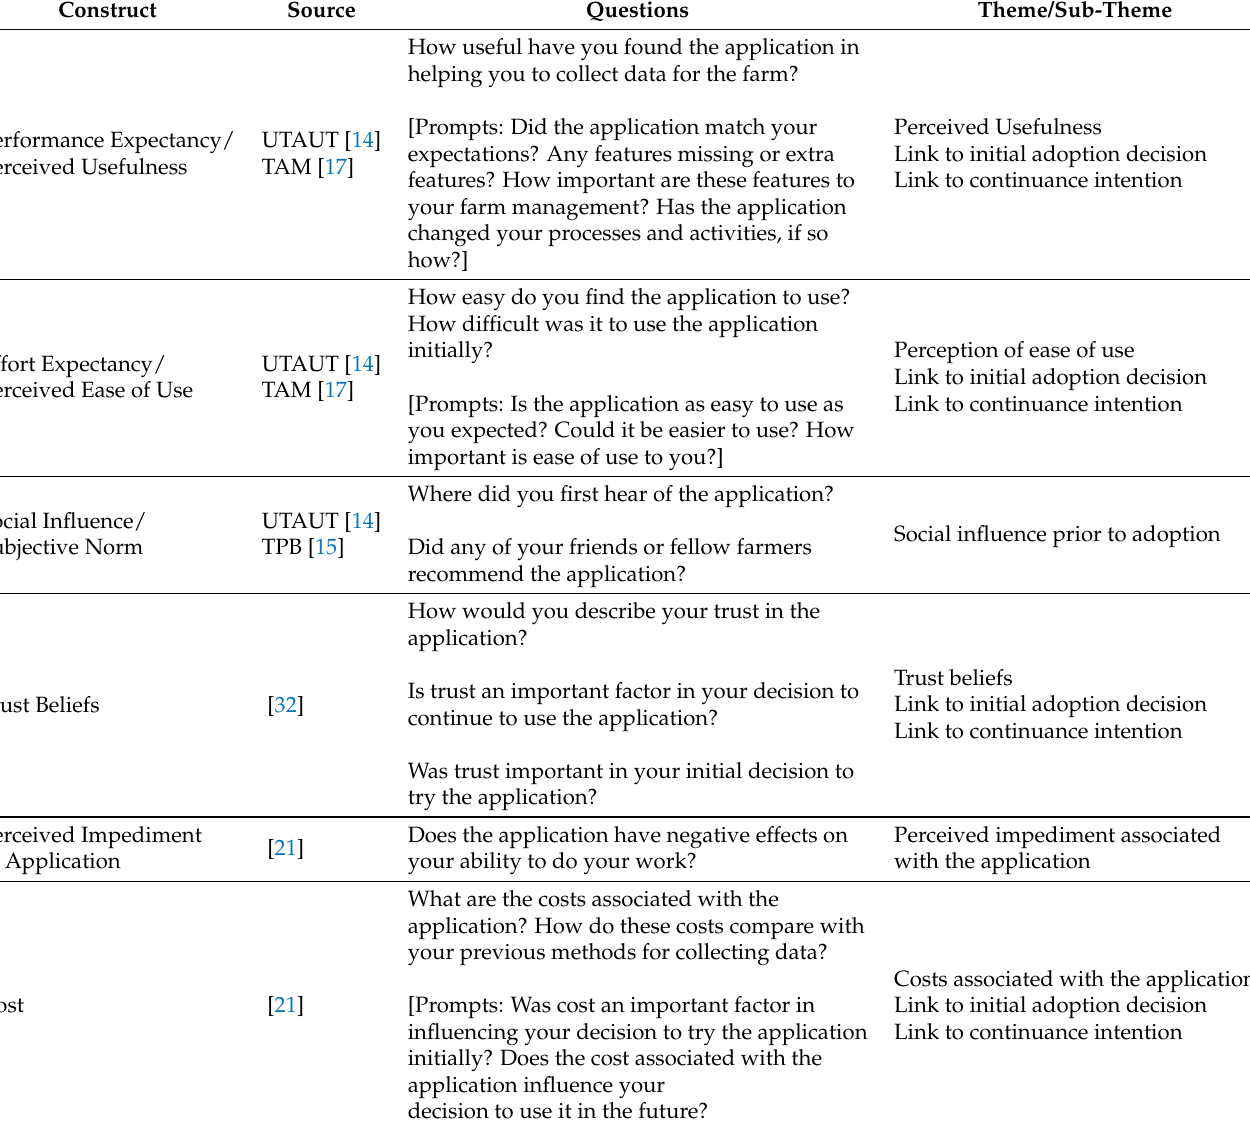
Table A1. Topic guide: User focus